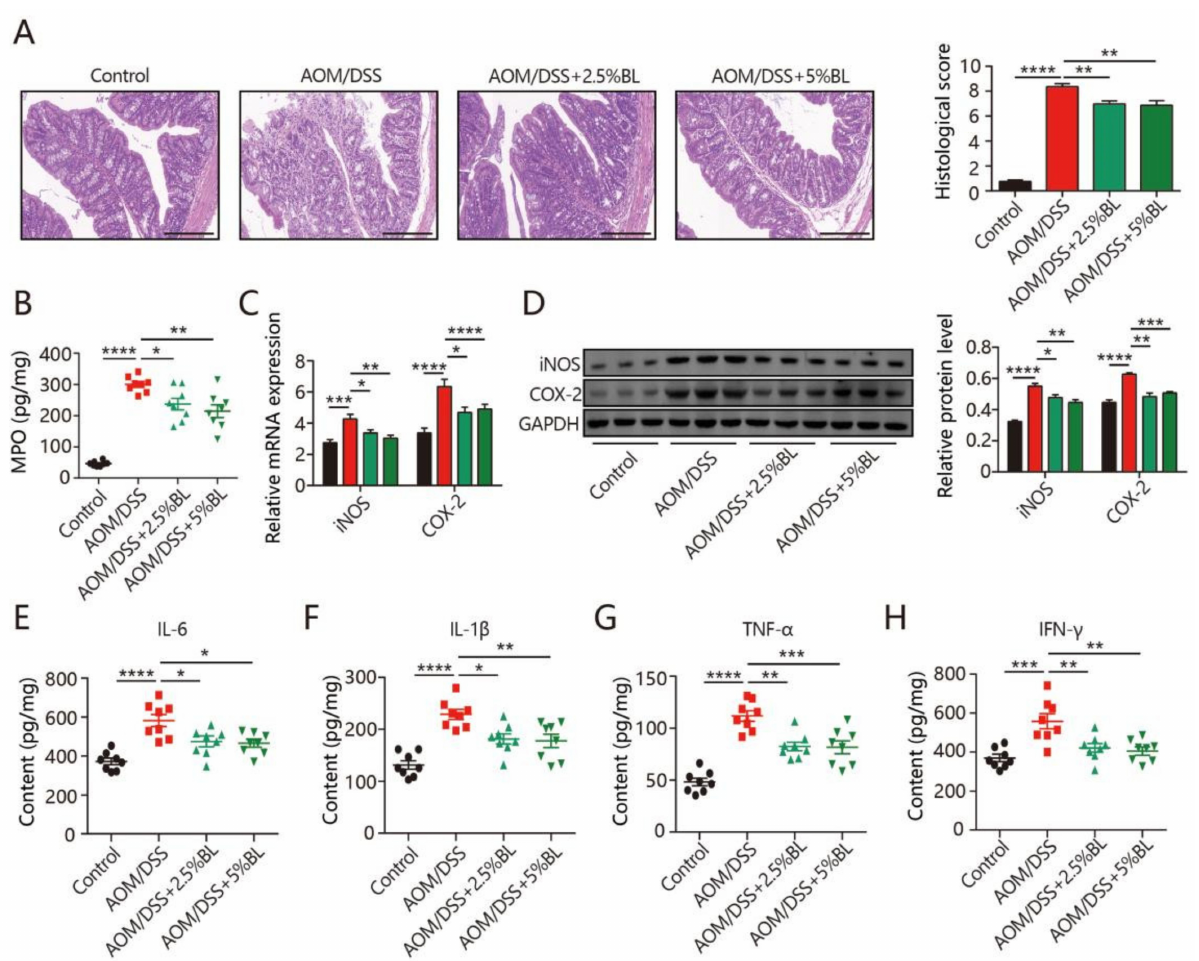
Figure 2. BL inhibits AOM/DSS-induced inflammatory mediators. ( A ) The histological score and images of HE staining in colon (400 × ). ( B ) The level of myeloperoxidase (MPO). ( C , D ) The levels of inducible nitrogen oxide synthase (iNOS) and cyclooxygenase 2 (COX-2), and ( E – H ) the levels of interleukin (IL)-6, IL-1 β , tumor necrosis factor (TNF- α ), and interferon (IFN)- γ in the colonic tissues ( n = 8–10). Data are mean ± SEM. * p < 0.05, ** p < 0.01, *** p < 0.001, and **** p < 0.0001. BL, barley leaf; AOM, azoxymethane; DSS, dextran sodium